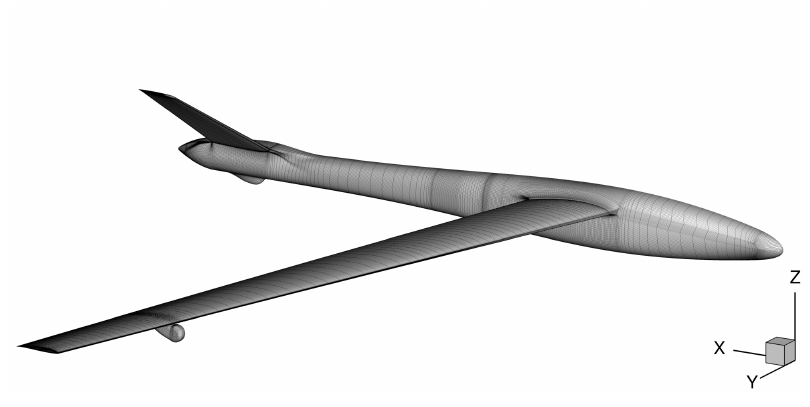
Figure 13. Surface grid of FAC.